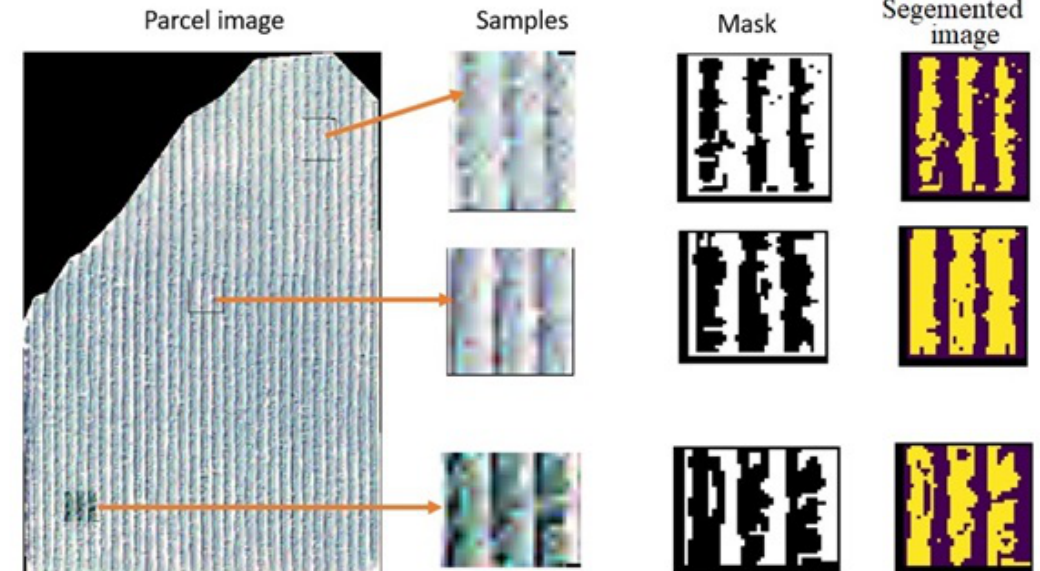
Figure 10. Examples of the samples, maks, and the segmented image